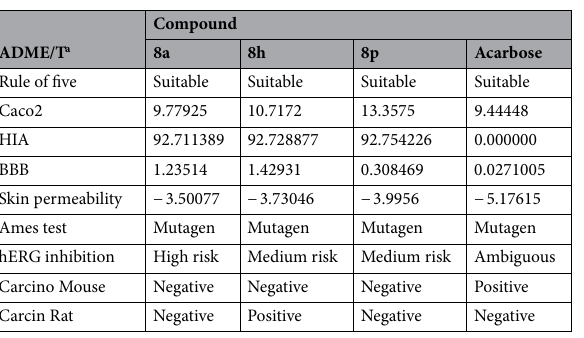
Table 2. Druglikeness/ADME/T profile of the most potent compounds 8a , 8h , 8p , and standard drug acarbose. a The recommended ranges for Caco2: < 25 poor, > 500 great, HIA: > 80% is high < 25% is